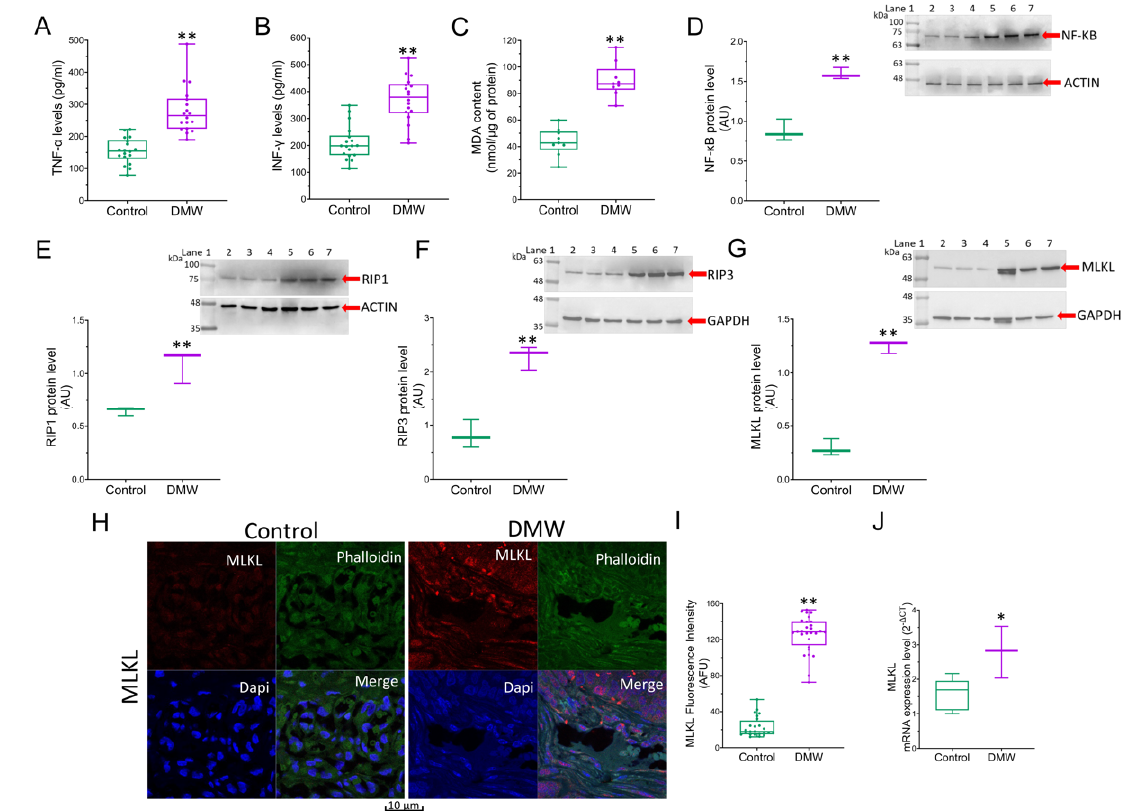
Figure 3. DMW activates inflammation and necroptosis in xenograft model of colorectal cancer. ( A , B ) Expression levels detected by ELISA assay of TNF- α and INF- γ , ( C ) MDA content and ( D – G ) immunoblotting analysis of NF- κ B, RIP1, RIP3, and MLKL in control and DMW-treated mice. ( H – J ) Representative immunofluorescence images, analysis, and mRNA expression of MLKL in control and DMW-treated mice. Fluorescence intensity determination, reported as boxplots representing the densitometric mean values of arbitrary fluorescence units (AFU). For immunoblotting study, boxplots represent the densitometric mean values, expressed as arbitrary units (AU) of n = 5 different experiments. Protein expression was determined after normalisation with α -tubulin or GAPDH as internal control, with ImageJ software. Lane 1 = molecular marker; Lanes 2, 3, and 4 = control mice; Lanes 5, 6, and 7 = DMW-treated mice. * p < 0.05 vs. control mice; ** p < 0.01 vs. control mice.